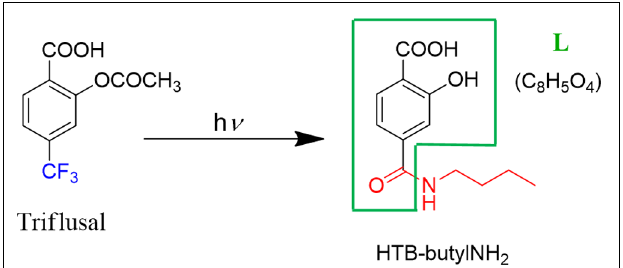
FIGURE 5 | Photoadduct HTB-butylNH 2 formation.